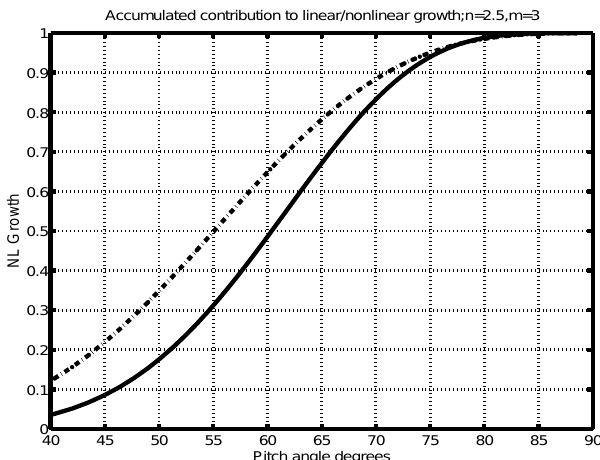
Fig. 5. Accumulated fractional linear and nonlinear growth rates, as functions of pitch angle for a low anisotropy distribution function n = 2 . 5, m =